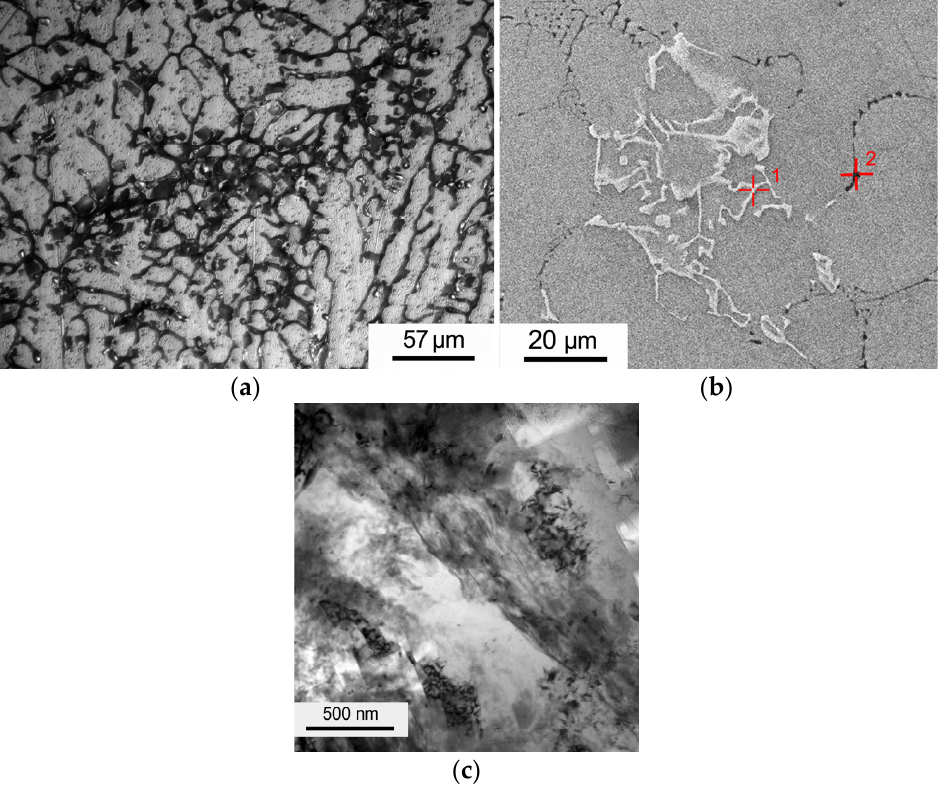
Figure 5. AlMgGr composite structure after dynamic compression: ( a )—zones with various grain morphologies; ( b )—eutectic; ( c )—area of fragmented structure (TEM).